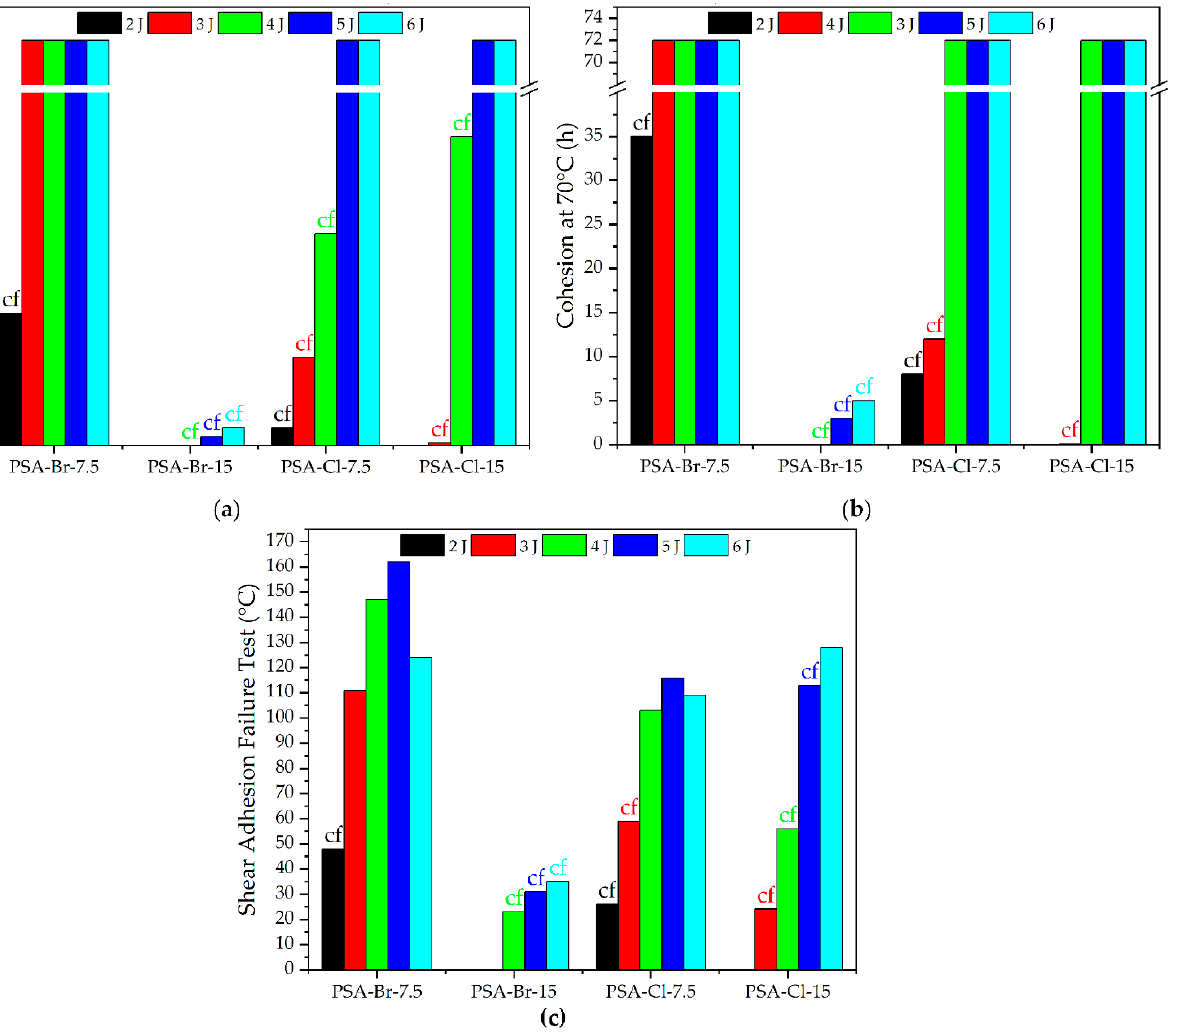
Figure 5. Cohesion at 20 °C ( a ) and 70 °C ( b ) and the SAFT ( c ) of PSAs based on acrylic telomer syrup.